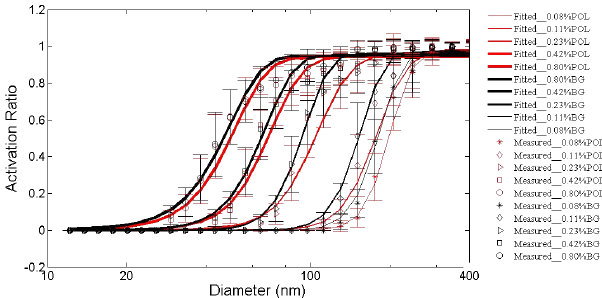
Figure 1. Averaged measured and fitted CCN efficiency spectra from the 3-parameter CDF fits at SS = 0.08, 0.11, 0.23, 0.42, and 0.80% under polluted (POL) and background (BG) conditions dur- ing the size-resolved CCN measurement